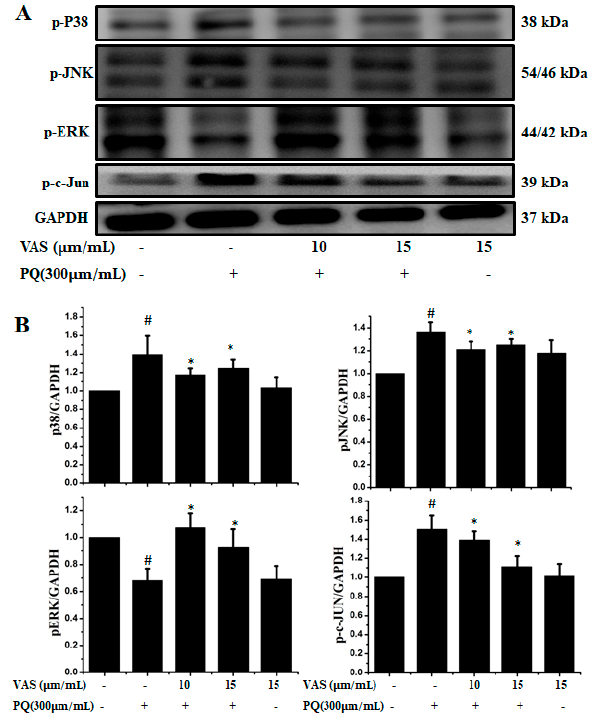
Figure 3. E ff ect of vasicinone on the paraquat-induced expression of MAP kinases in SH-SY5Y cells. ( A ) Cells were preincubated with vasicinone for 24 h, and paraquat (300 µ M) was added for an additional 24 h. The protein expression levels of MAP kinases were measured using Western blotting analysis. GAPDH (glyceraldehyde-3-phosphate dehydrogenase) was used as an internal standard protein. ( B ) Phosphorylation of the p38, JNK1 / 2, p-ERK1 / 2 and c-JUN were determined by densitometry of the blots. Three independent experiments were performed. Results are shown as the mean ± SD. # p < 0.01, significantly di ff erent from control cells; * p < 0.01, compared with paraquat-treated cells.